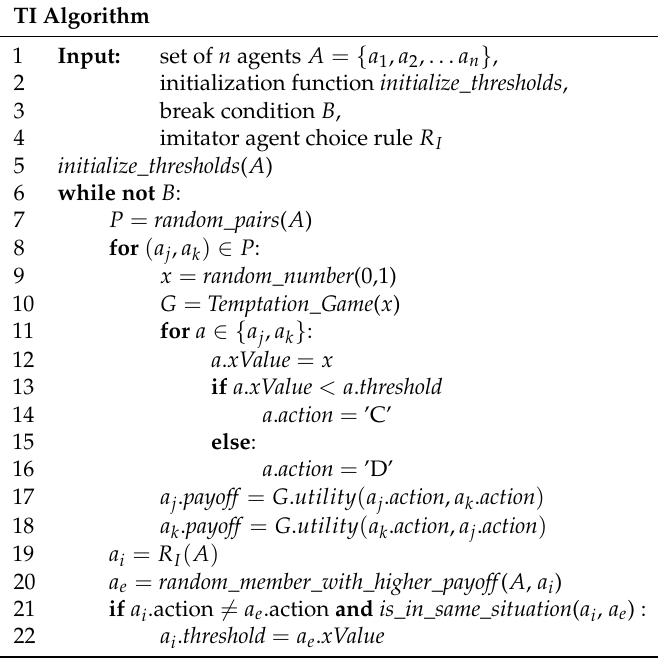
Figure 1. The TI algorithm (Threshold